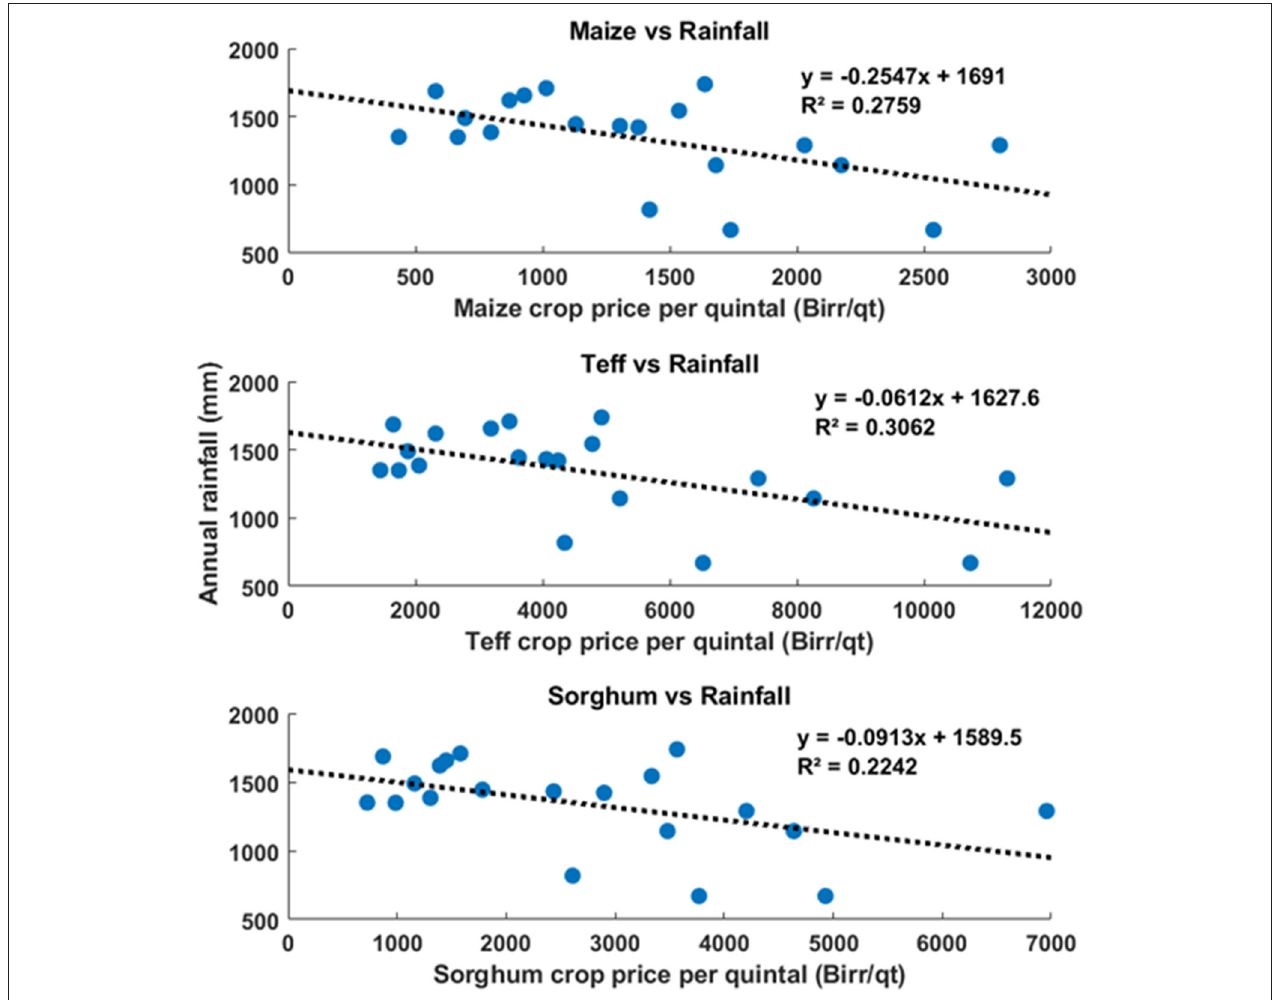
FIGURE 8 | Scatter plots of the prices of dominants crops vs. annual rainfall amounts. In general crop prices fall in years with higher